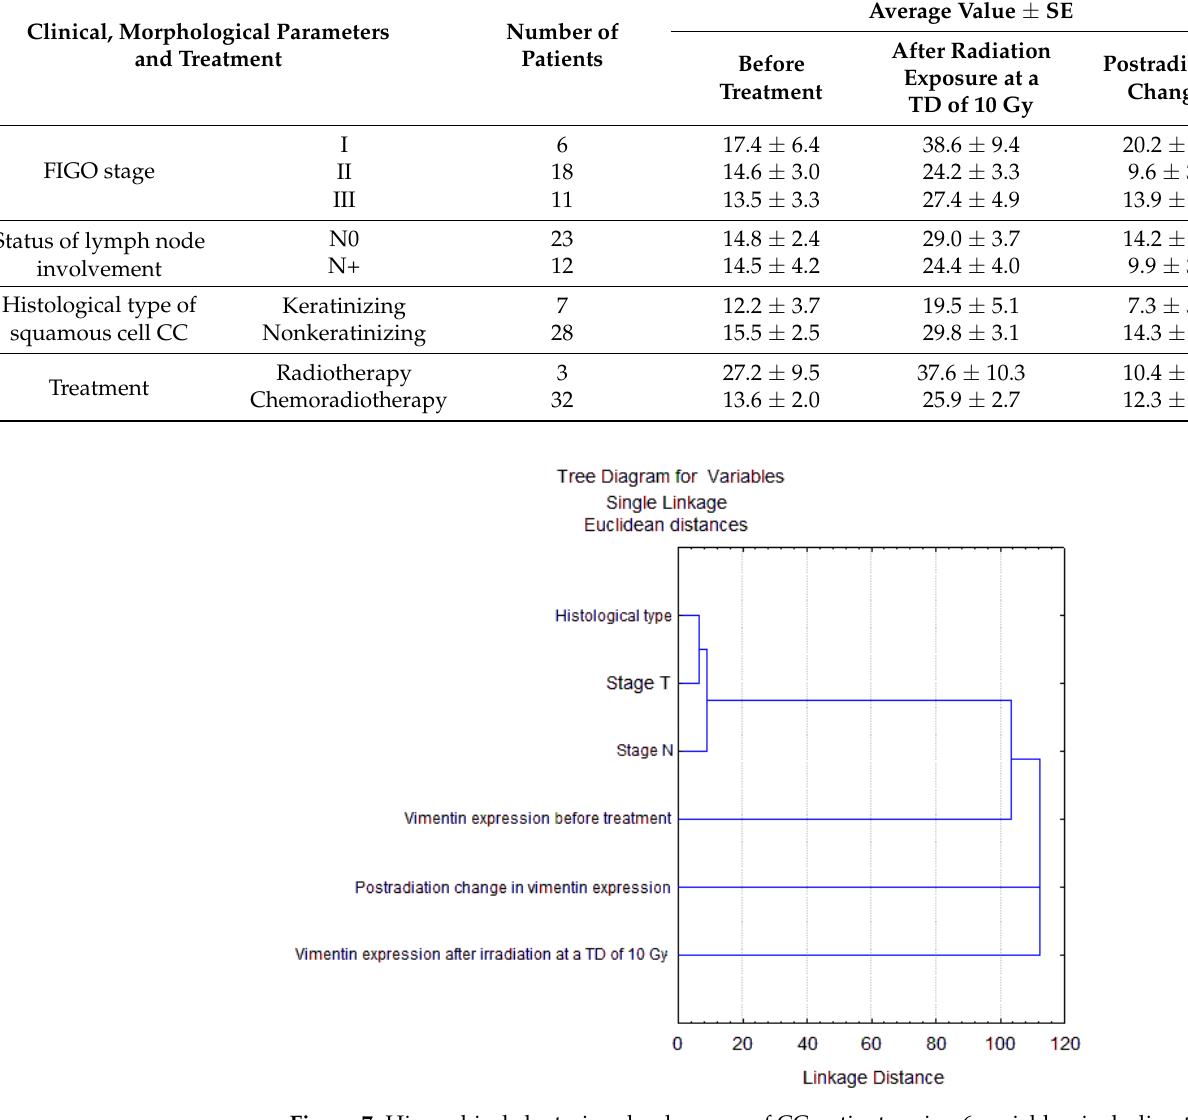
Figure 7. Hierarchical clustering dendrogram of CC patients using 6 variables, including the main clinical and morphological parameters and data on vimentin expression assessed by proportion of vimentin-positive cancer cells before and after radiation exposure at a TD of 10 Gy ( n = 35). Clinical and morphological parameters are closely associated with each other (Euclidean distances < 10), but not with vimentin expression (Euclidean distances > 100). An inverse correlation of postradiation changes in the proportion of vimentin-positive cancer cells with the initial number of these cells before treatment was revealed (R = − 0.36, p = 0.03) (Figure